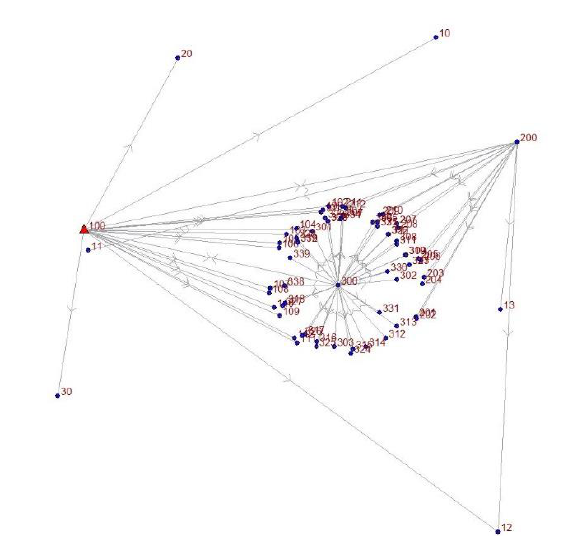
Figure 3. Plan view of photogrammetry and topography points.